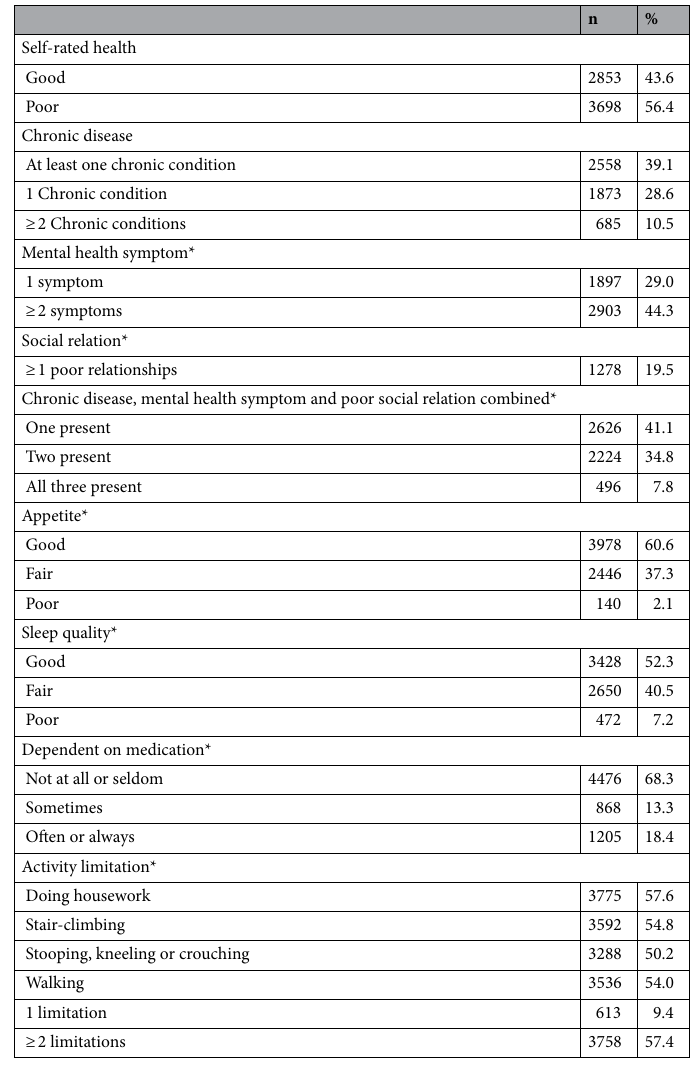
Table 2. Prevalence of reported health conditions (n = 6 551). *Data of some participants were